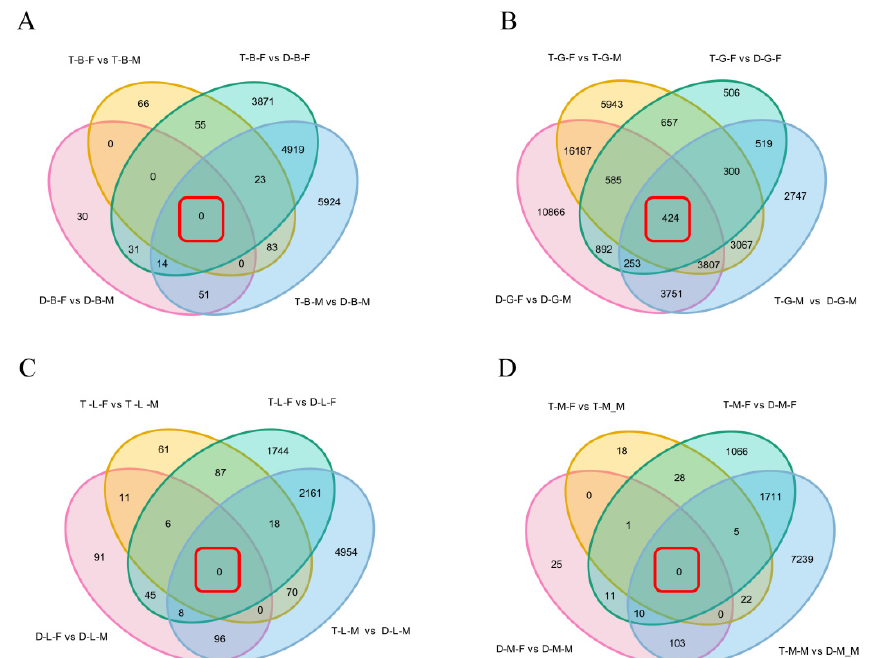
Figure 4. Venn diagram of shared and unique DEGs in brain ( A ), gonad ( B ), liver ( C ), and muscle ( D ) of four comparison groups. The red box indicates the number of DEGs overlapping among the four comparison